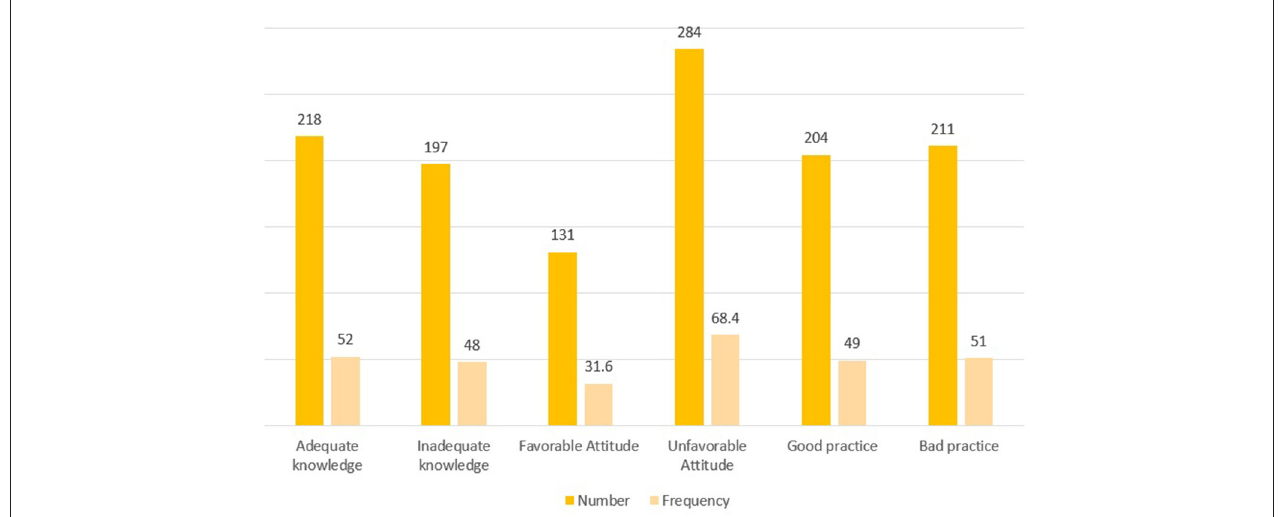
FIGURE 2 | Distribution of knowledge, attitude, and practice toward COVID-19 among the Dire Dawa Administration residents, Eastern Ethiopia, September 2020.